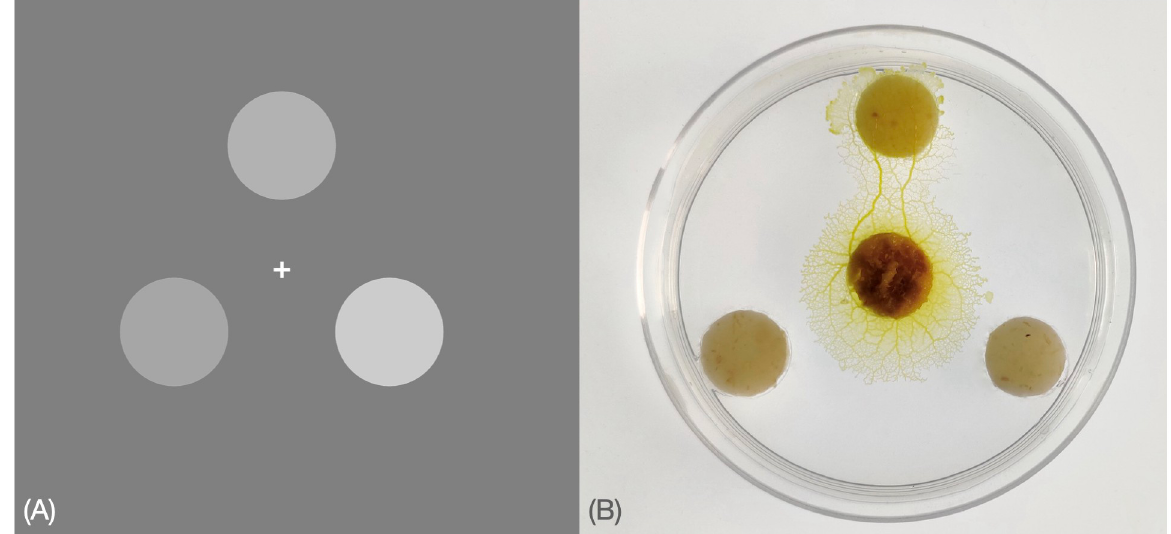
Fig 7. (A) Stimuli example for human psychophysical experiments: Participants were requested to decide as fast and accurately as possible which of the three stimuli was brighter; they were asked to maintain fixation on the cross at the centre of the screen and minimise distraction for the short duration of the experiment. Unknown to participants, conditions of interest were conditions for which the stimuli had equal mean brightness. (B) Photograph showing a slime mould that chose one food alternative among three equal ones. The slime mould was placed in the centre of a petri dish (60 mm ⌀ ) filled with agar gel (10 g.L − 1 ) at a distance of 2 mm from each food